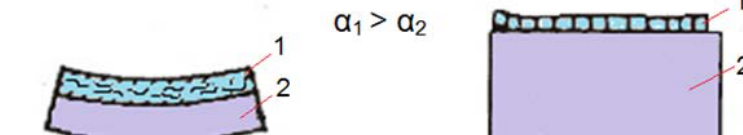
Figure 3 – Stresses in the coating for α 1 > α 2 Рис . 3 – Напряжения в покрытии для α 1 > α 2 Слика 3 – Напони у превлаци за α 1 > α